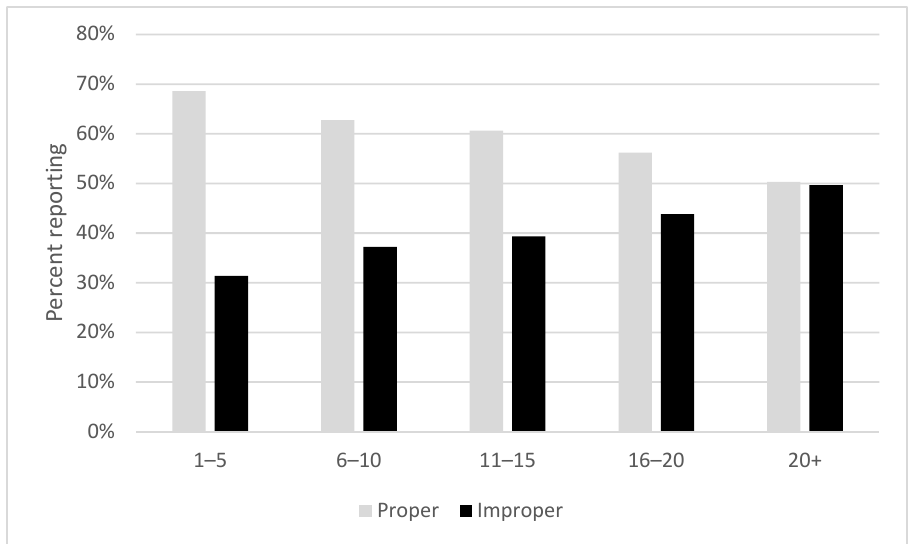
Figure 2. Disposal of last cigarette smoked by daily consumption, normalized to size of each group ( n = 7532).